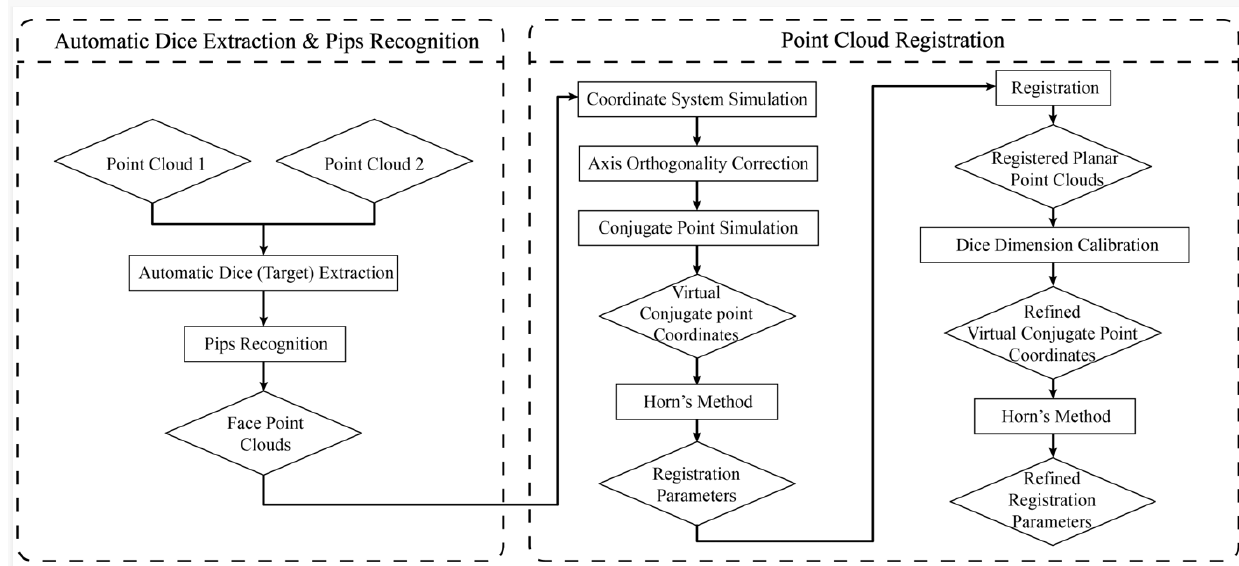
Figure 3. Workflow of the proposed point cloud registration method.